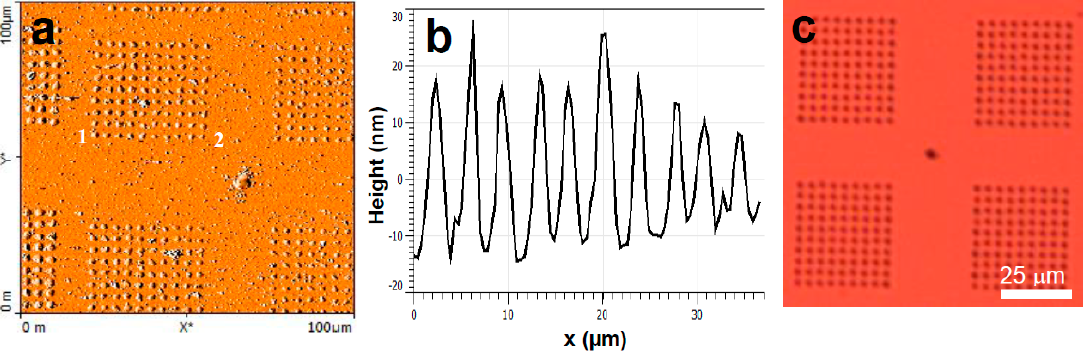
Figure 2. ( a ) Representative atomic force microscopy (AFM) topography image of a substrate patterned with reporter DNA dissolved in trehalose buffer, ( b ) representative corresponding cross-section profile along the line between points 1 and 2 marked in ( a ), and ( c ) representative optical microscopy image of a substrate patterned with reporter DNA dissolved in trehalose buffer.